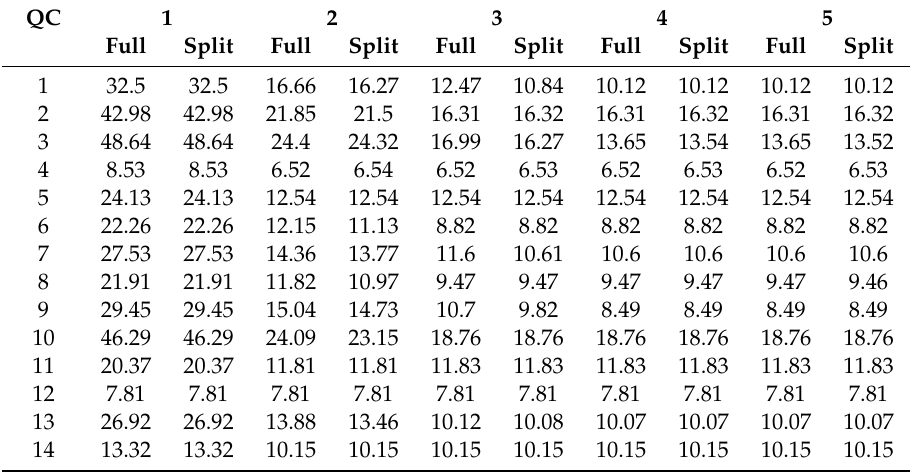
Table A2. The output from the QCSP solution report (2 modes of operation, scenarios with 1–5